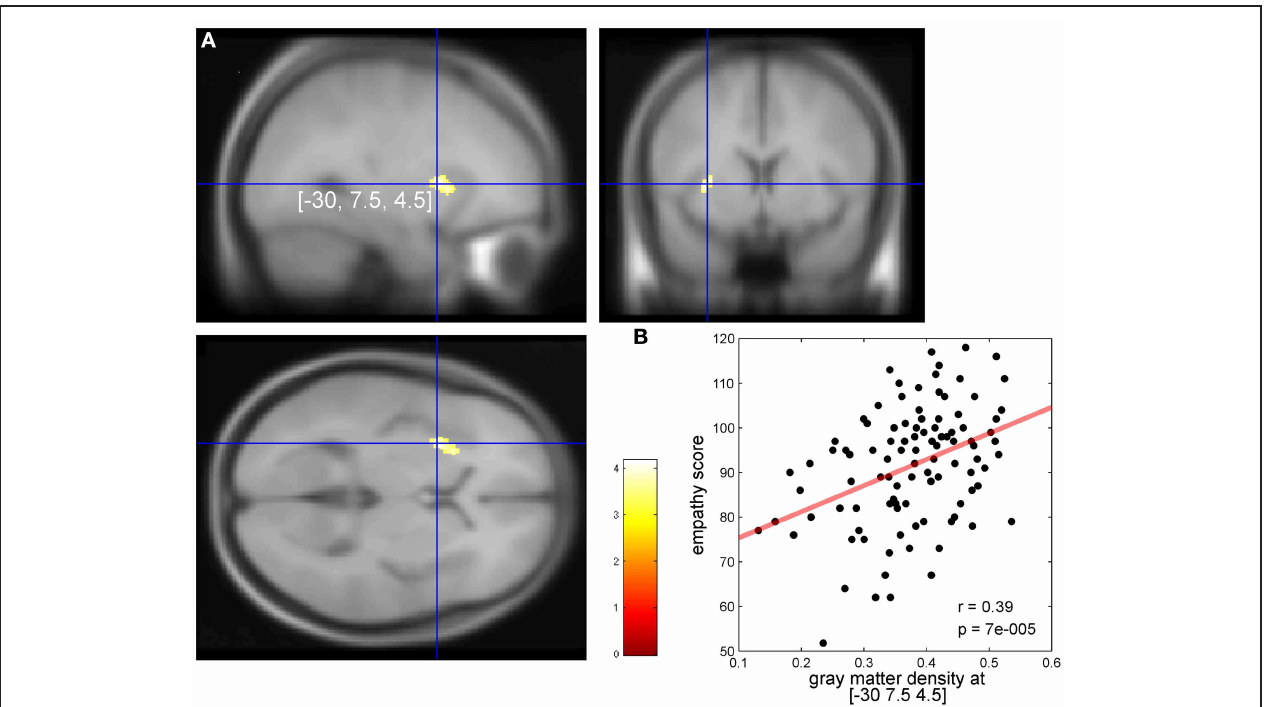
FIGURE 1 | (A) Significant correlation in the left dorsal anterior insular cortex (AIC) between individual empathy scores in 101 healthy females and individual cortical gray values ( p < 0 . 001). Axial slice at the (MNI) x/y/z coordinate [ − 30, 7.5, 4.5] (global, maximal correlation). T -values are color-coded. (B) Correlation of individual gray matter density (arbitrary units)